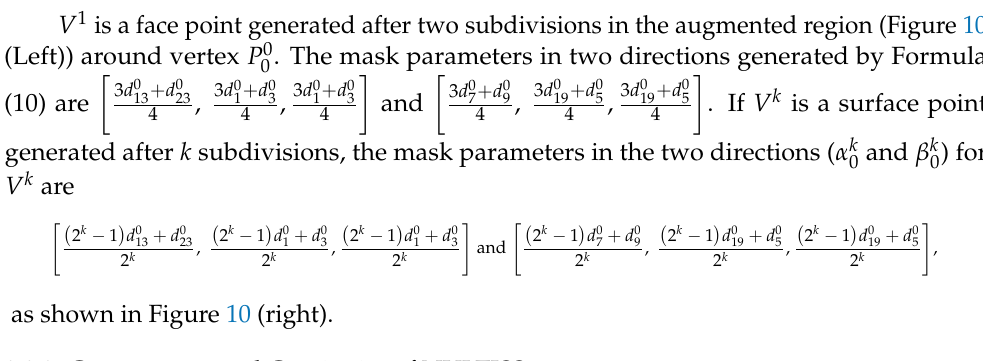
Figure 10. Left: updating of the mask parameters around the vertex after two subdivisions. Right: the mask parameters around the vertex after 𝑘 subdivisions.